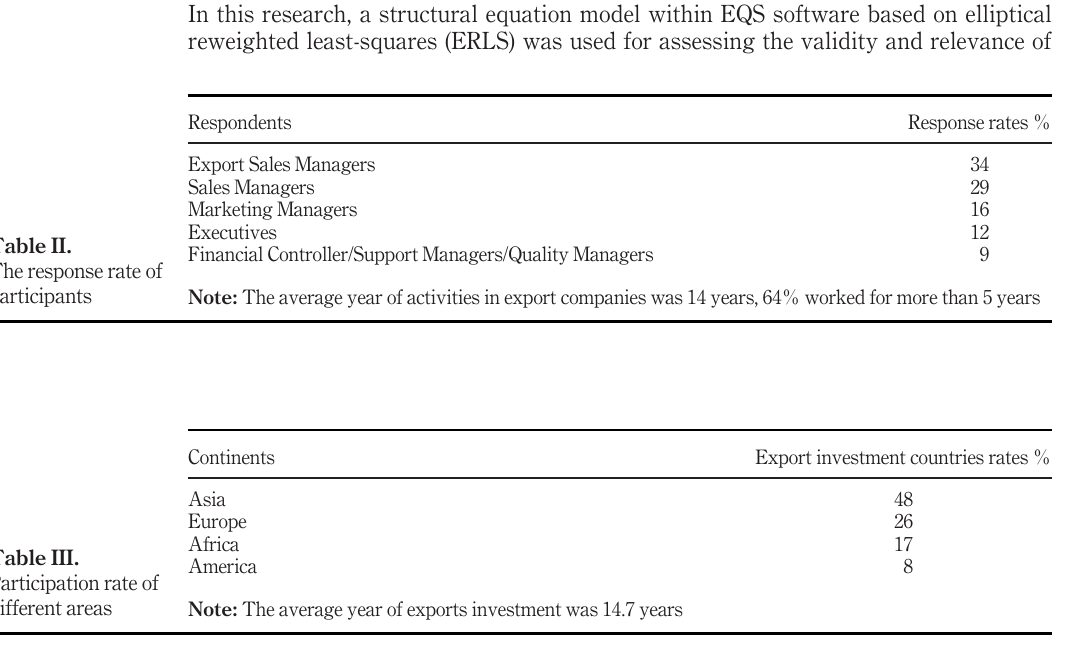
Table III. Participation rate of different areas